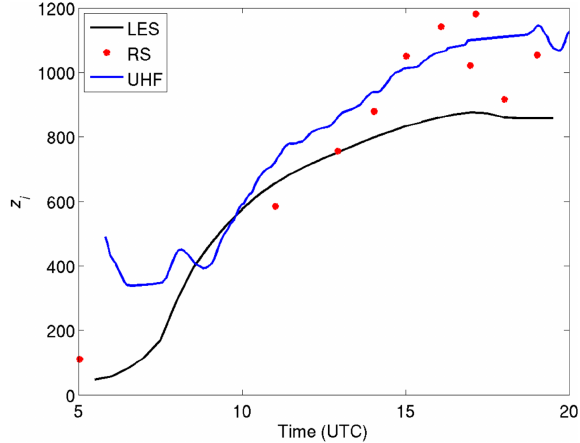
Figure 7. Temporal evolution of the resolved TKE (subscript RES) at different heights in the simulation (different colours). TKE de- duced from aircraft and surface (subscript OBS) spectra integrated over the LES spectra wave number range (open and filled circles, respectively). The vertical dashed lines stand for the times of max- imum surface buoyancy flux (at 12:00UTC) and its zero value (at